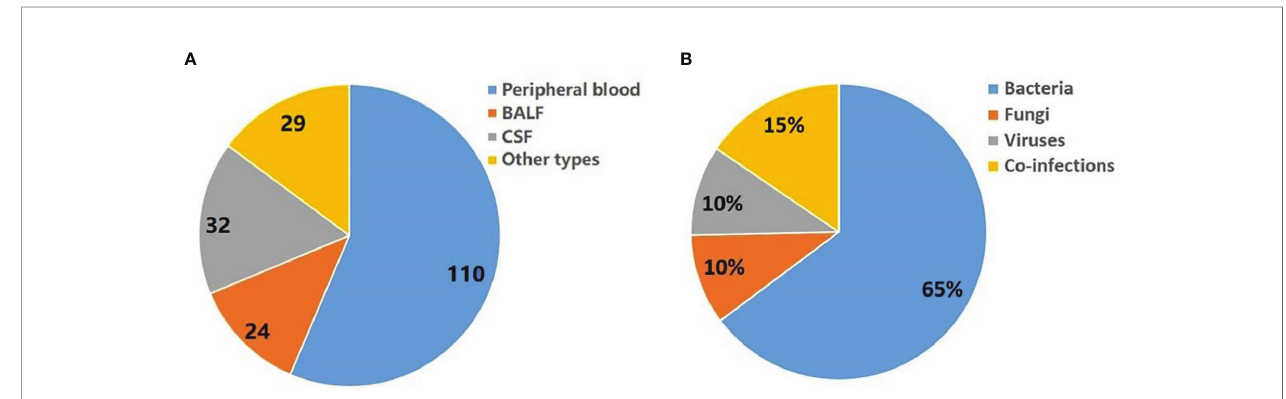
FIGURE 1 | Summary of pathogens detected by mNGS. (A) Sample types tested in this study. Other types including sputum, pleural fl uid, ascites, and pericardial effusion. (B) Distribution of infection types (bacteria, viruses, fungi and co-infection) in 140